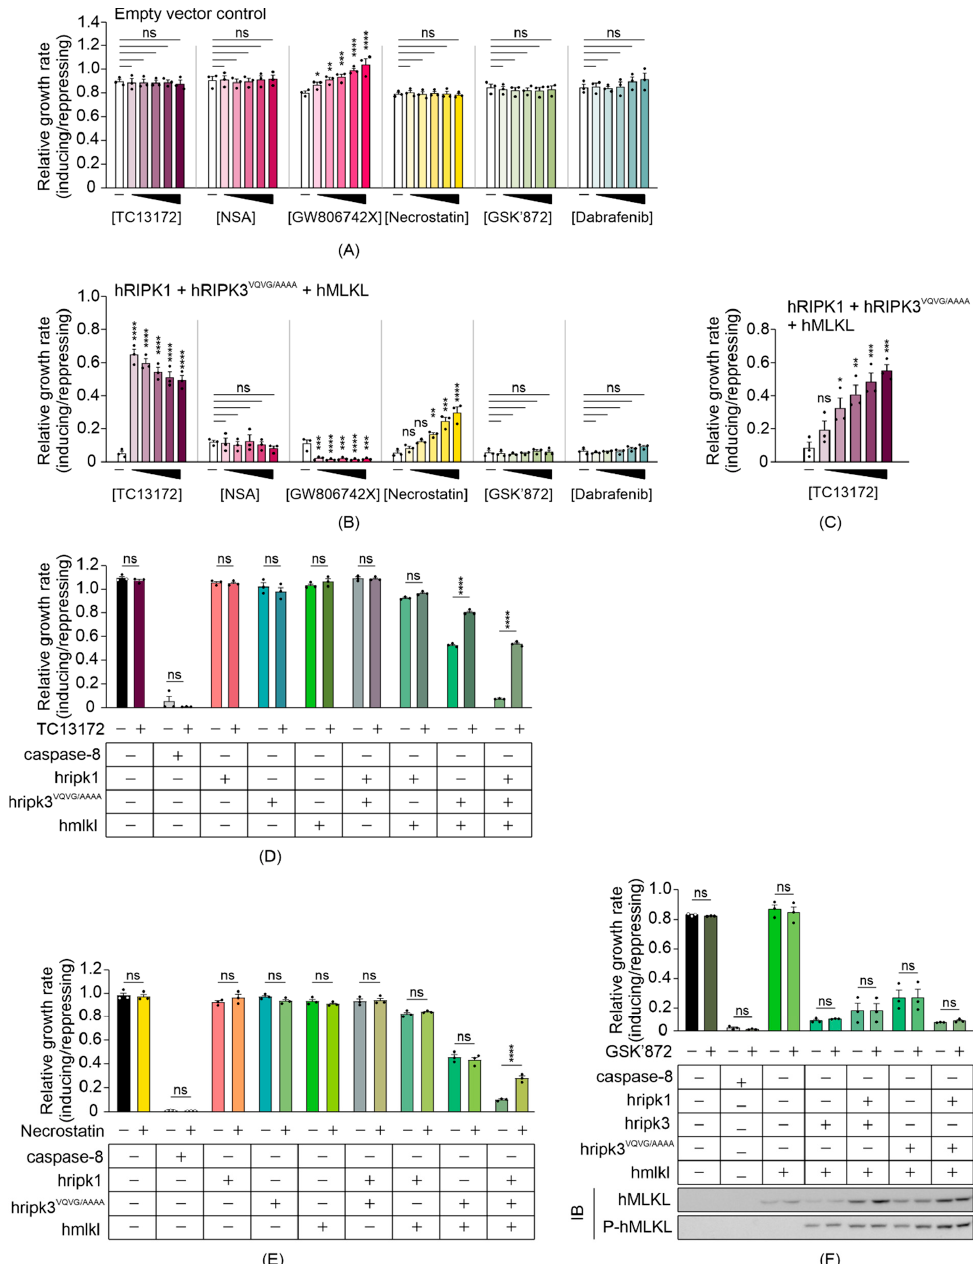
Figure 4. TC13172 and necrostatin inhibit necrosome interaction-induced yeast lethality. Maximal growth rates of yeast bearing ( A ) empty vectors or ( B , C ) expression plasmids encoding human wild-type MLKL, RIPK1 and RIPK3 VQVG/AAAA in inducing versus repressing liquid media with different concentrations of indicated small molecule necroptotic inhibitors. Differences in growth rates of yeast in media either without drugs (-) or containing ( A , B ) 20, 40, 60, 80 or 100 µ M of TC13172, NSA, GW806742X, necrostatin, GSK’872 or Dabrafenib; or ( C ) 4, 8, 12, 16 or 20 µ M of TC13172 (increasing concentrations indicated by black triangle) were compared. Graphs present mean ± SEM of three independent assays. The effects of ( D ) 20 µ M TC13172, ( E ) 100 µ M necrostatin or ( F ) 100 µ M GSK’872 on the growth rates of yeast expressing either MLKL, RIPK3, RIPK3 VQVG/AAAA or RIPK1 or co-expression of two or three transgenes were assessed by monitoring the change in absorbance of yeast cultures in inducing and repressing media. The effect of GSK’872 on proliferation and MLKL phosphorylation of yeast bearing various transgenes were assayed ( F ). Differences in growth rates of untreated versus drug-treated yeast were compared using ANOVAs with Sidak corrections ( A – F ). Graphs present mean ± SEM of three independent assays. *, p < 0.05; **, p < 0.01; ***, p < 0.001; ****, p < 0.0001; ns, not